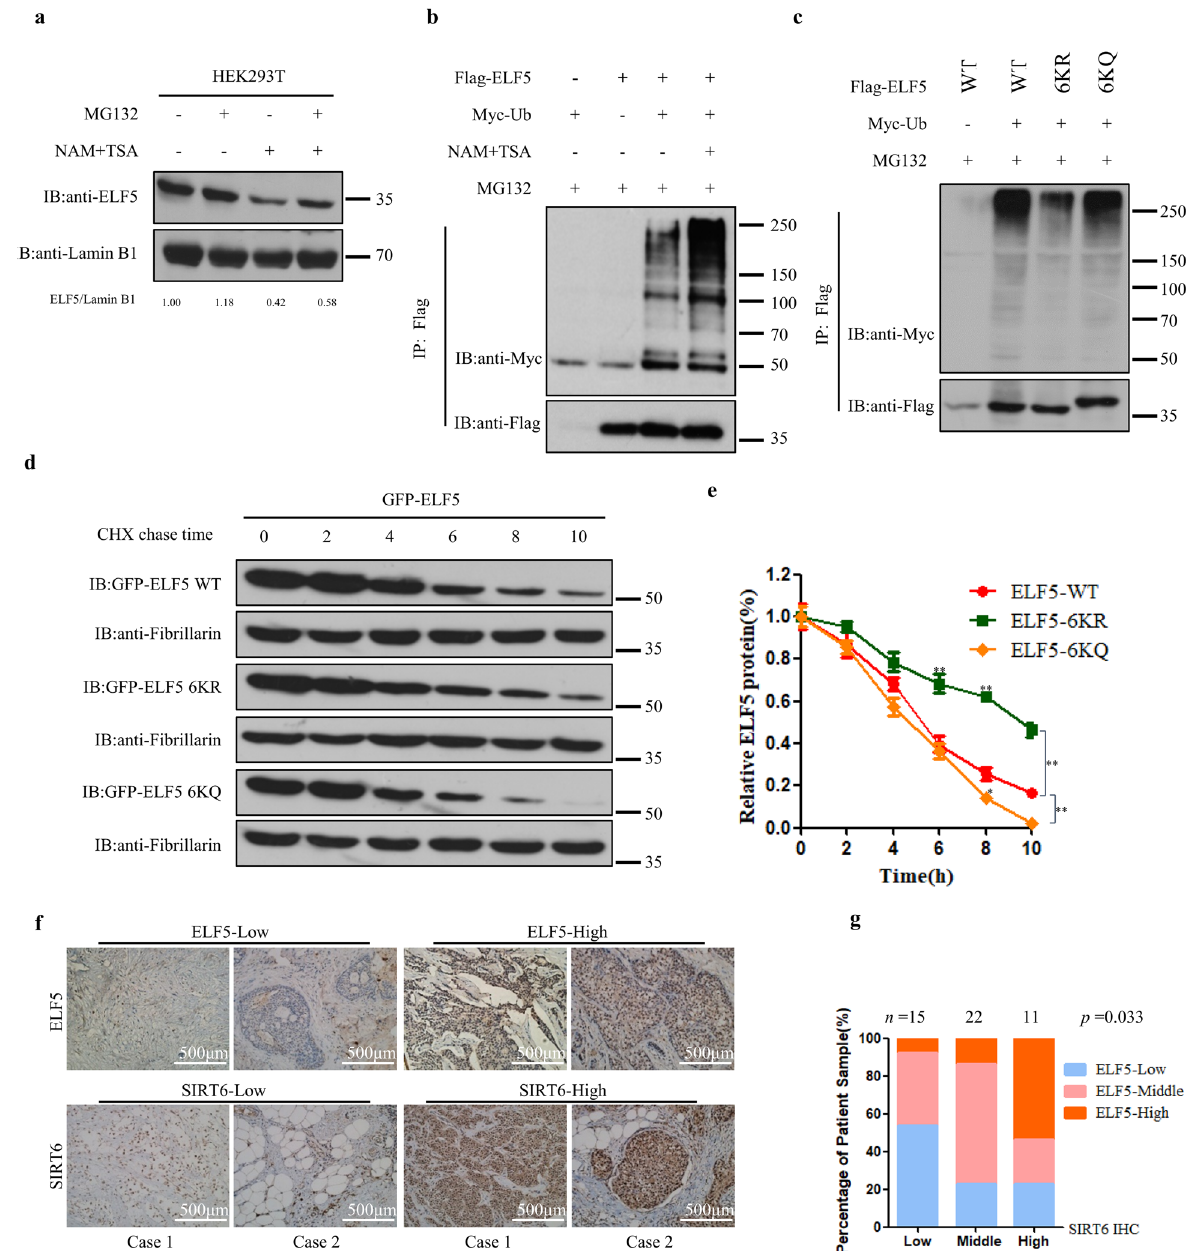
Fig. 5 Acetylation promotes the proteasome-mediated degradation of ELF5. a Inhibition of deacetylation and protein synthesis on the protein level of ELF5. HEK293T cells were treated without and with 2 μ M TSA and 5 mM NAM in the absence or presence of 20 μ M MG132. Endogenous ELF5 was probed by anti-ELF5 Ab. b NAM- and TSA-mediated regulation of the ELF5 ubiquitination. Ubiquitination of Flag-ELF5 expressed in HEK293T cells the absence and presence of NAM + TSA with MG132. c Quantitation of the ubiquitination levels of Flag-ELF5 WT, Flag-ELF5 6KR, and Flag-ELF5 6KQ in HEK293T cells. d , e Half-lives of ELF5 and mutants. HEK293T cells expressing GFP-ELF5-WT, GFP-ELF5-6KR, or GFP-ELF5-6KQ were treated with 50 μ M Cycloheximide, and the expression levels of these proteins were analyzed by western blot with anti- GFP Ab. The graph shown represents the ELF5 half-lives in Fig. 5e. Data are the means ± SDs from three determinations. * p < 0.05; ** p < 0.01. f , g The expression of ELF5 and SIRT6 in human breast cancer tissues. Representative images tissue samples from breast cancer patients showing the expression levels of ELF5 and SIRT6 as assessed by immunohistochemistry. Both ELF5 and SIRT6 levels were classi fi ed as low, medium, or high based on the intensities of their IHC staining, and the percentages of patients classi fi ed in each category are depicted in the histogram in Fig. The acetylation of transcription factors may exert either a stimulatory or inhibitory effect on the transcription of target genes via a variety of mechanisms. Acetylation can enhance the stability of SMAD7 and p53 49,52,53 , but disrupts the stability of DNMT1 and PEPCK1 54,55 . At present, other relevant factors contributing to the stability of ELF5 have not been studied. The predicted